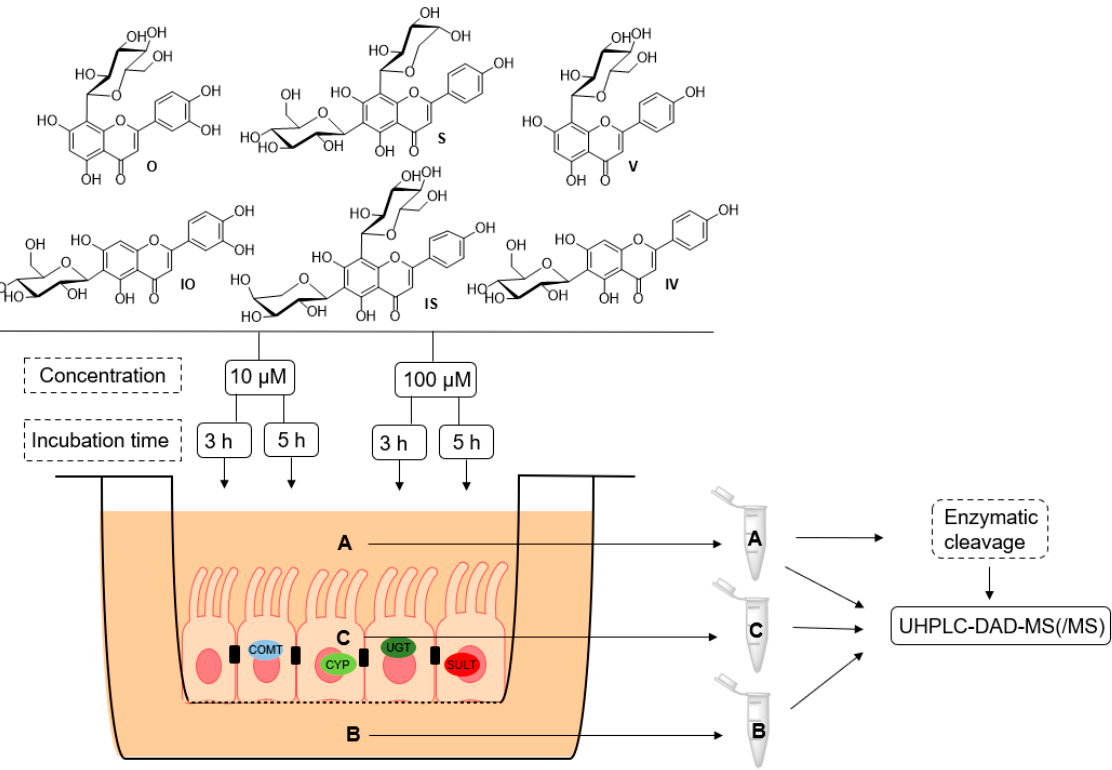
Figure 2. Schematic overview of the metabolic experiments on orientin (O), isoorientin (IO), schaftoside (S), isoschaftoside (IS), vitexin (V), and isovitexin (IV), with different incubation times and concentrations, using the Caco-2 monolayer model; A: apical, B: basolateral, C: cell lysate, COMT: catechol-O-methyltransferase, UGT: UDP-glucuronosyltransferase, SULT: sulfotransferase, CYP: cytochrome P450.